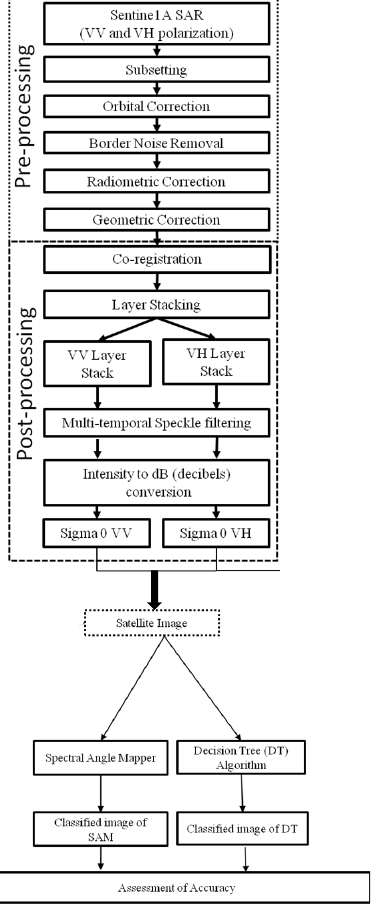
Figure 2: Methodology for classification for multi-temporal SAR data